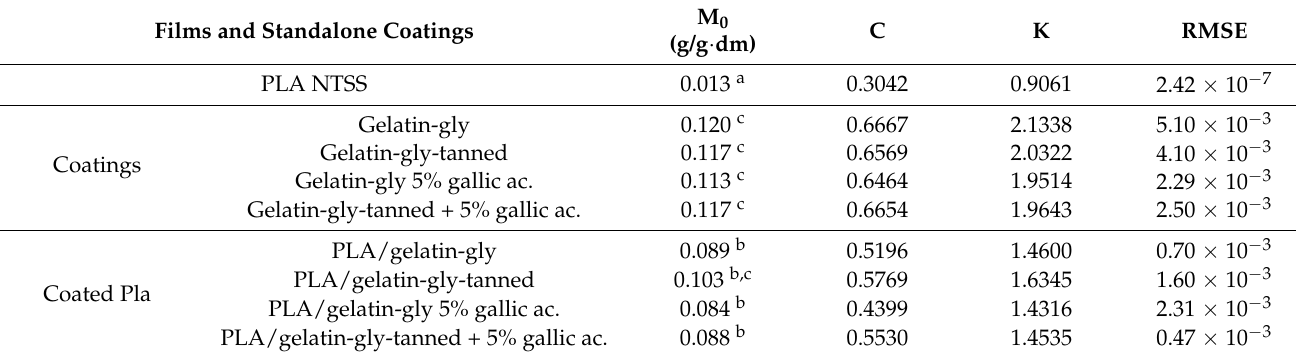
Table 1. GAB model values of samples: M 0 monolayer water content, C and K constants, and the RMSE of the GAB model fitting (at 25 ◦